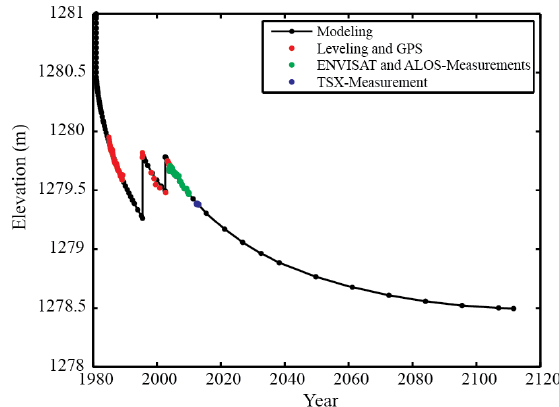
Figure 7. The settlement–time plot of one point on the top of the rock-fill at the cross section 4.0